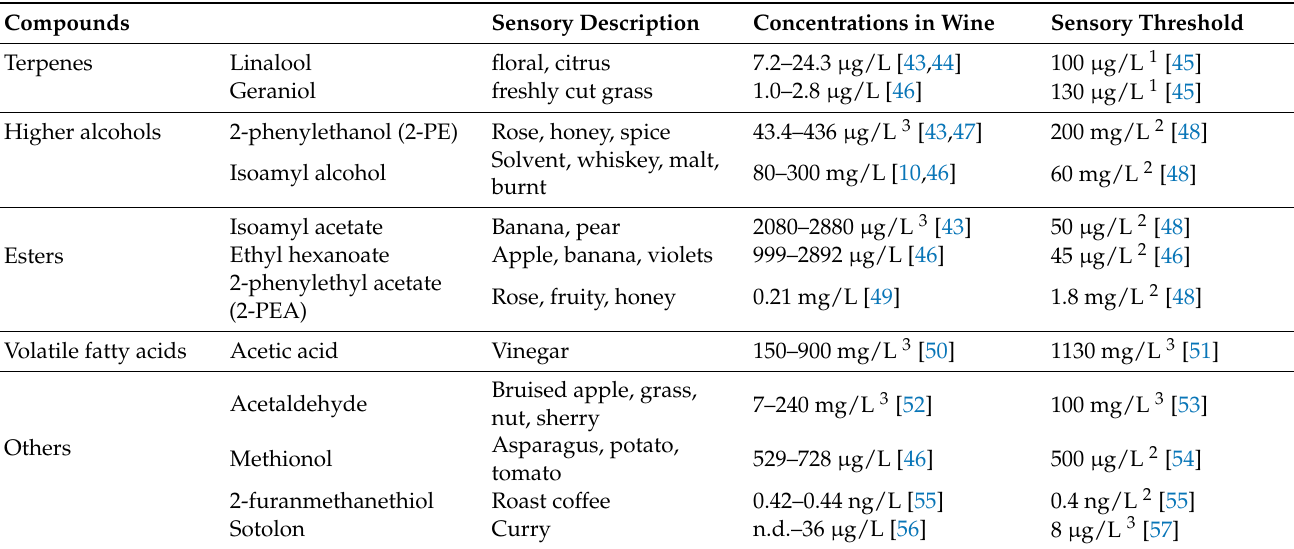
Table 2. Other volatile compounds in Sauvignon Blanc